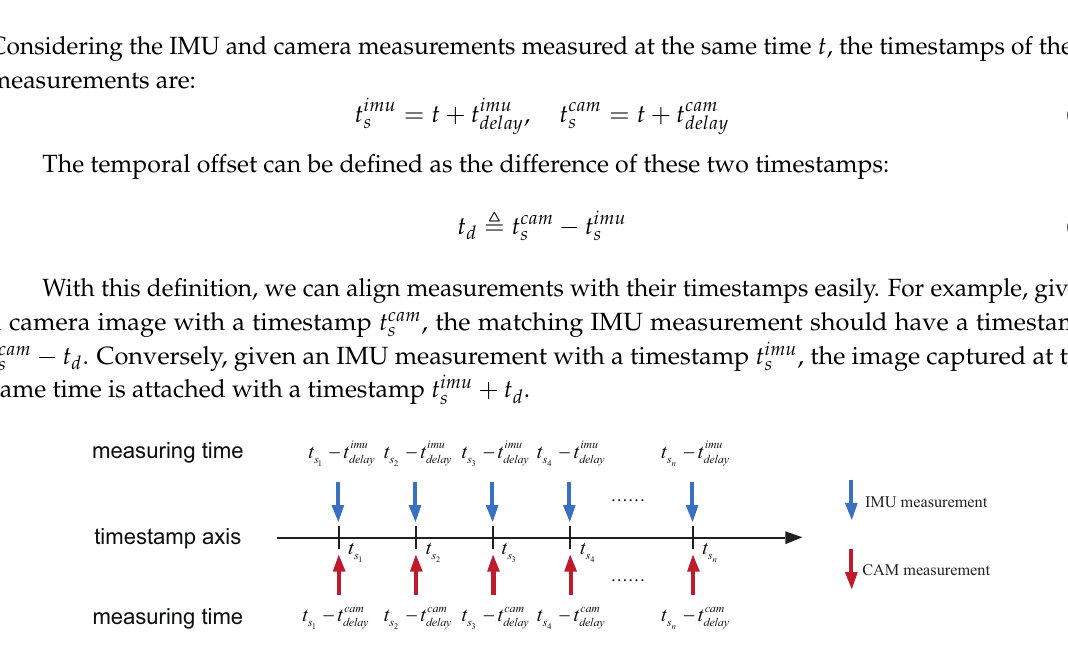
Figure 3. Misalignment of measurements: The IMU measurement and camera measurement with the same timestamp are not measured at the same time. In practice, we can only align sensor measurements according to their timestamps. However, it will result in a misalignment if these sensors suffer a different delay. To avoid this, we only need to shift the timestamp of one sensor from them (the camera or the IMU) with the temporal